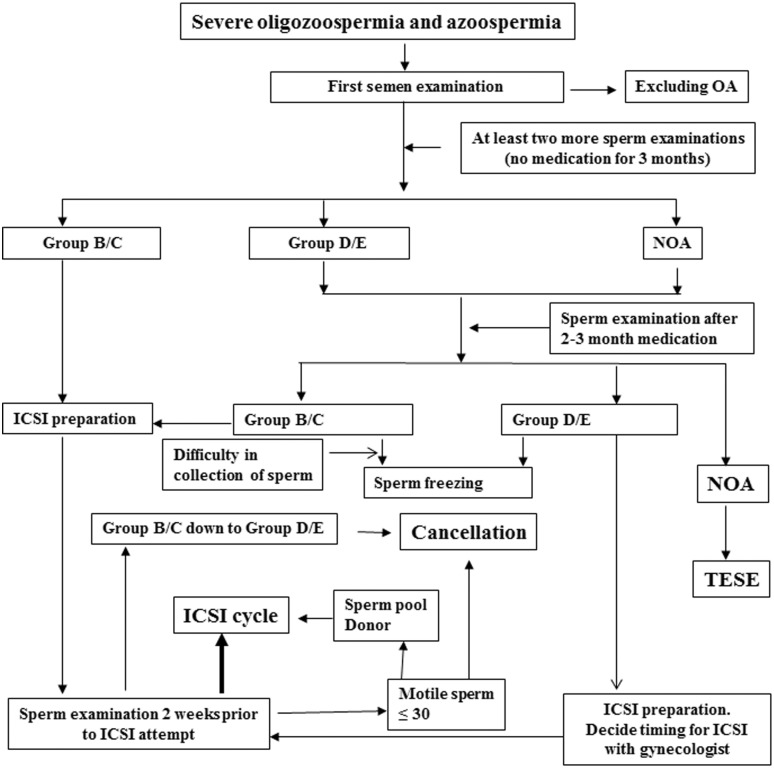
A proposal program of management of severe oligozoospermia and azoospermia.After differential diagnosis of obstructive azoospermia (OA), severe oligozoospermia was classified in according to the number of motile sperm from at least two ejaculates 4 weeks prior to ICSI attempt by andrologists. Proper medication might improve sperm motility. Cryopreservation was done for those having difficulty of collecting semen by masturbation and for Group D and E (motile sperm ≤ 1 × 105). Semen had to be examined again 2 weeks prior to ICSI attempt. ICSI might be suspended if motile sperm in Group B and C (motile sperm > 1 × 105) was down to the level of Group D and E, and these cases required further examination to determine next managements. Optional ICSI with patients’own pooled sperm or donor sperm, and cancellation of ICSI attempt was mainly recommended in the cases with extremely low number of motile sperm (≤ 30 in total). Non-obstructive azoospermia (NOA) could be treated with TESE if motile sperm was available.